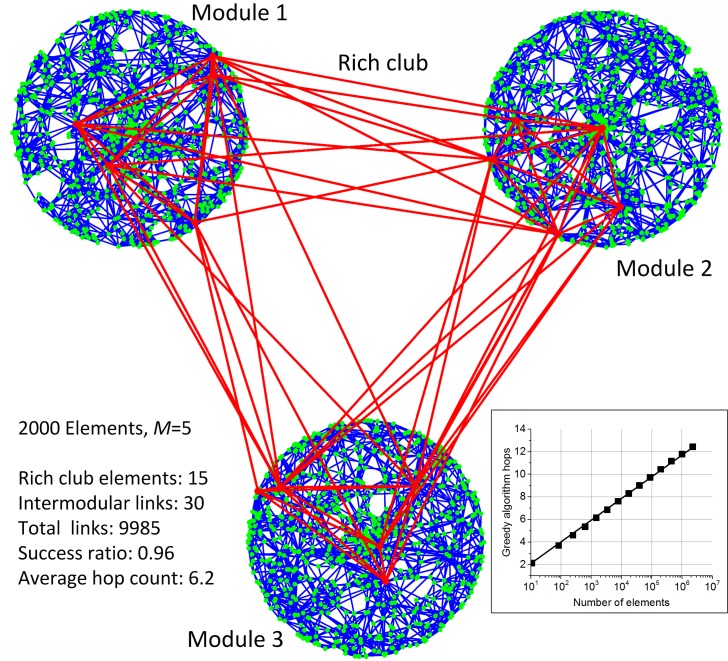
2D network constructed by the GH algorithm with M = 5 for clustered d = 2 Euclidian data.The inset shows scaling of the modified greedy algorithm average hop count.